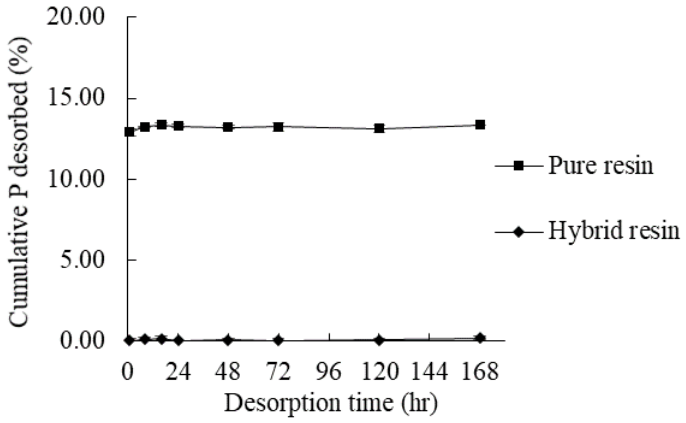
Figure 4. Phosphate release from a phosphate adsorbed pure resin and a phosphate adsorbed hybrid resin up to seven days. The initial phosphate loading level in both resins was 2 mg/g.